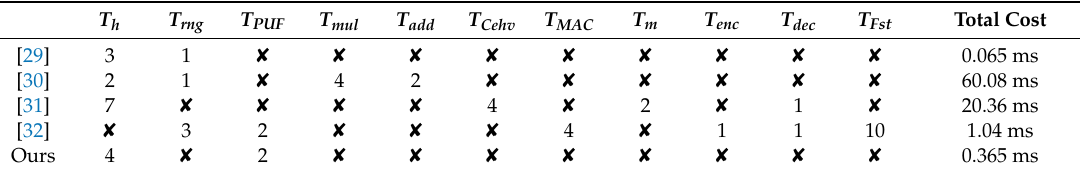
Table 4. Number of each cryptographic operation used in one execution of each protocol and the computational cost for CS.